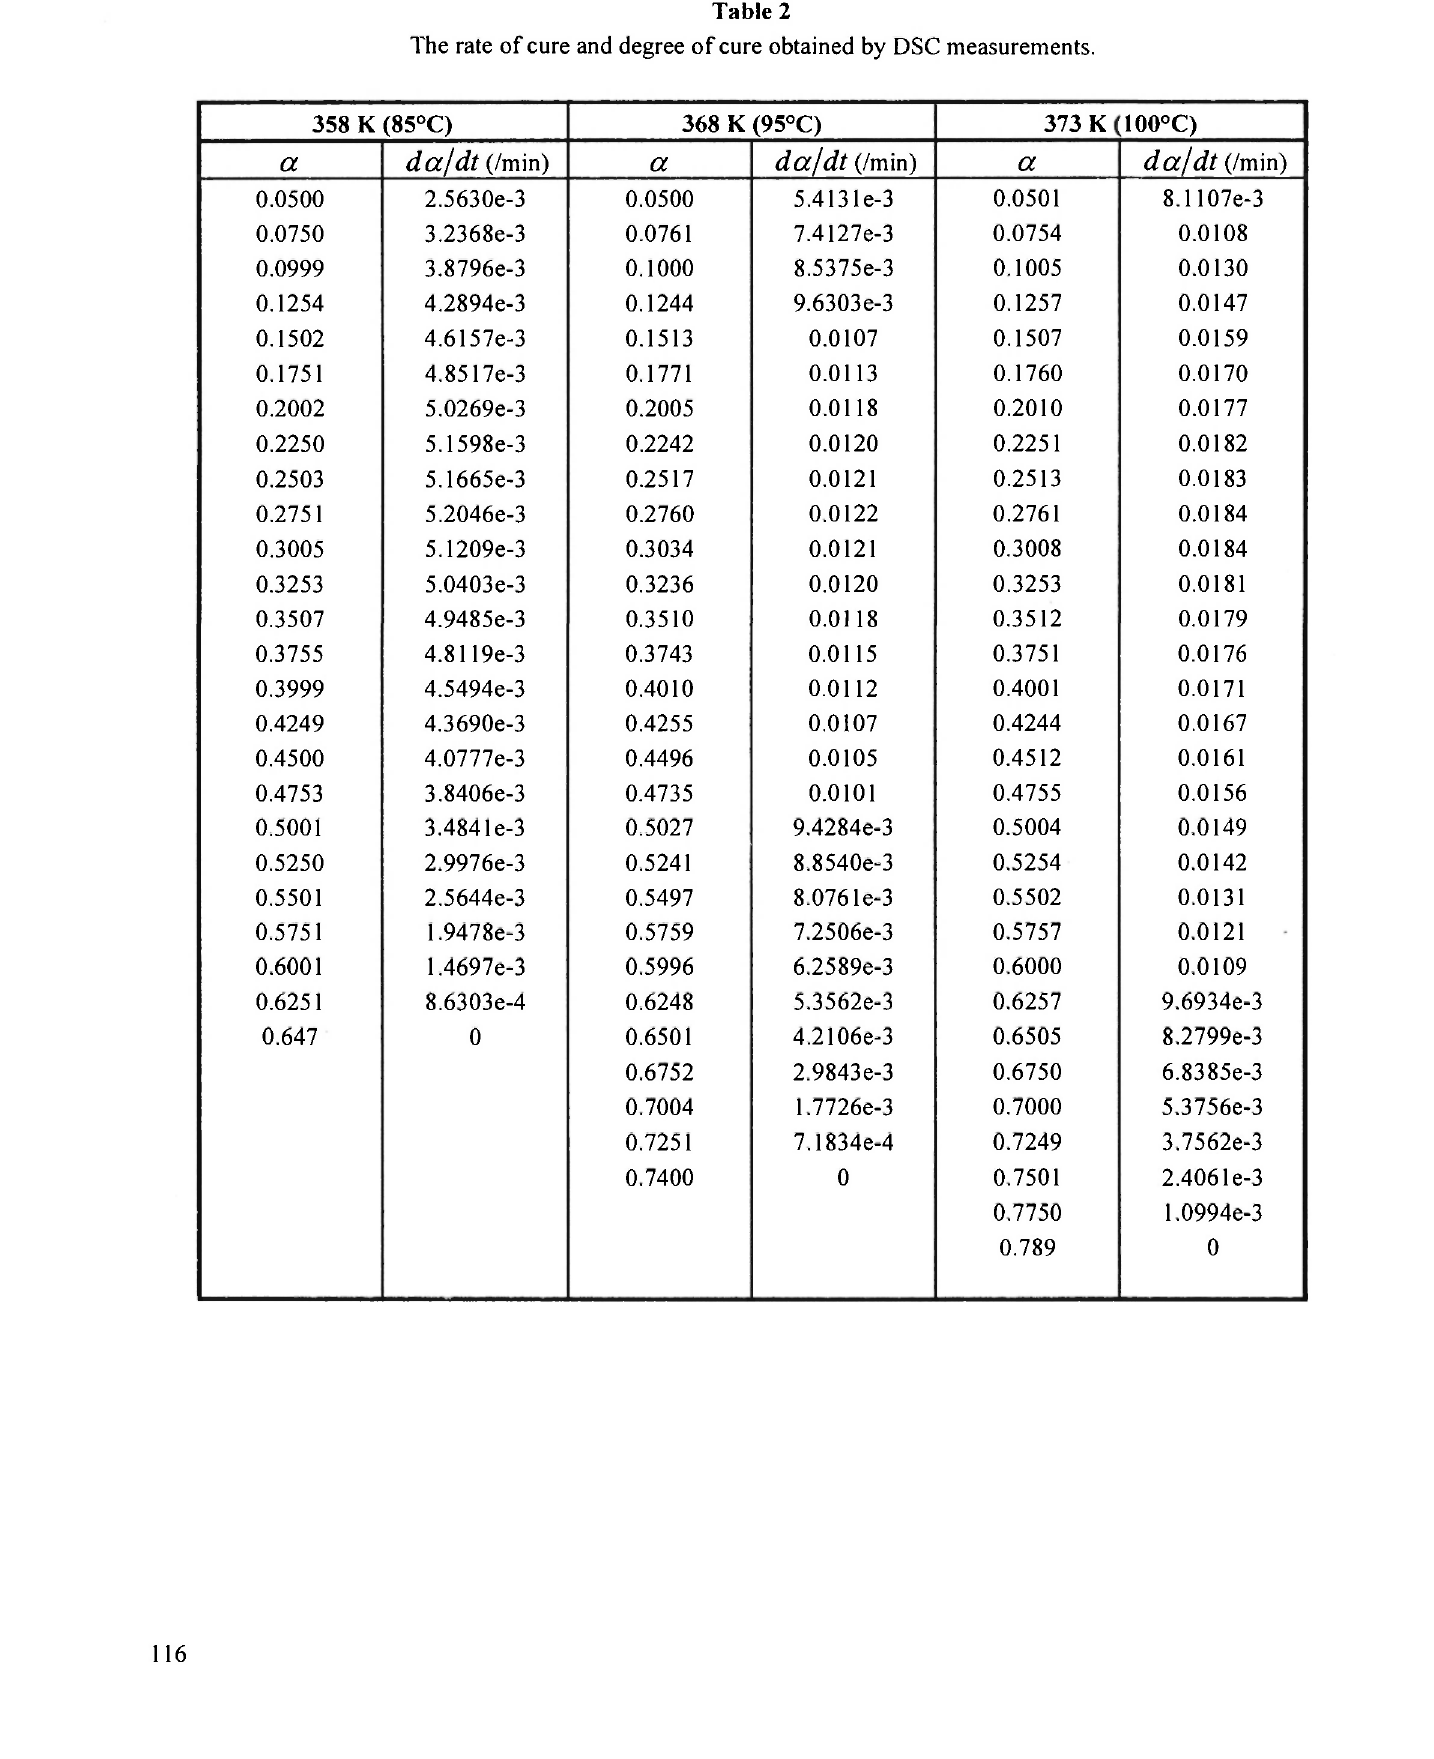
The rate of cure and degree of cure obtained by DSC